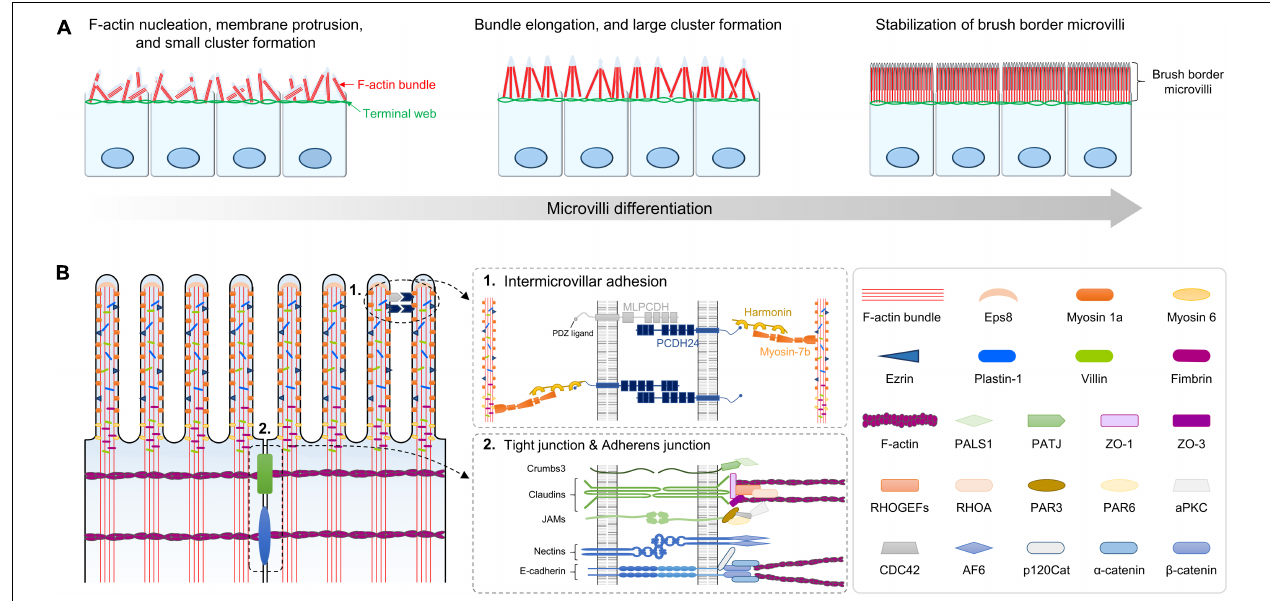
FIGURE 3 | Structure and composition of microvilli during brush border development. (A) Small cluster of microvilli on the apical surface is formed by the formation of F-actin bundles beneath the membrane. As microvilli differentiate, clusters elongate and form large cluster, ultimately resulting in stabilized brush border. (B) Molecular composition and two distinctive structures of the microvilli are shown. (cid:192) Intermicrovillar adhesion between the distal tips of microvilli is mediated by a heterophilic complex between protocadherin-24 (PCDH24) and mucin-like protocadherin (MLPCDH). The protocadherin complex is physically linked to the actin bundle through interaction with harmonin and myosin 7b. (cid:193) Molecular composition of tight junctions (TJs) and adherens junction at the lateral membrane of brush border. JAMs, junctional adhesion